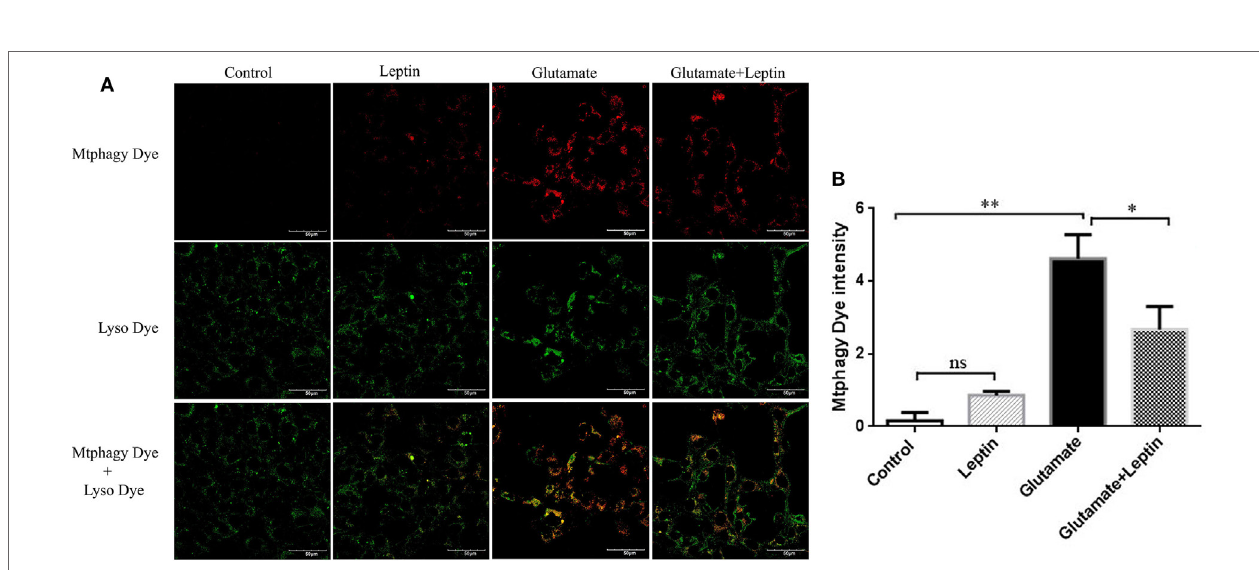
FigUre 5 | The effect of leptin on mitophagy induced by glutamate in HT22 cells. (a) The fluorescence intensity of Mtphagy Dye and Lyso Dye in mitochondria of HT22 cells; (B) the quantitative analysis of the average fluorescence intensity of mitochondrial Mtphagy Dye in HT22 cells. * P < 0.05, ** P < 0.01. ns, not significant.